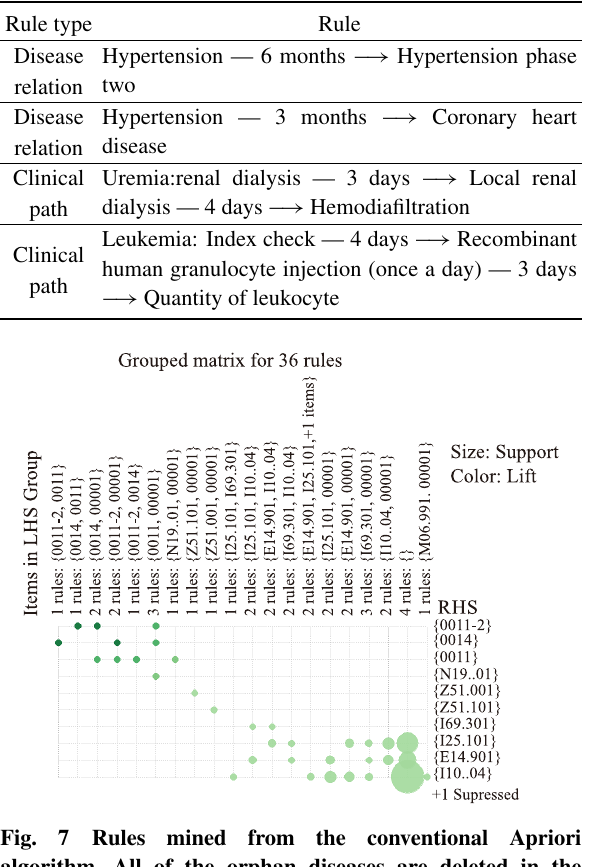
Table 1 Example of rules deduced from the community detection result.